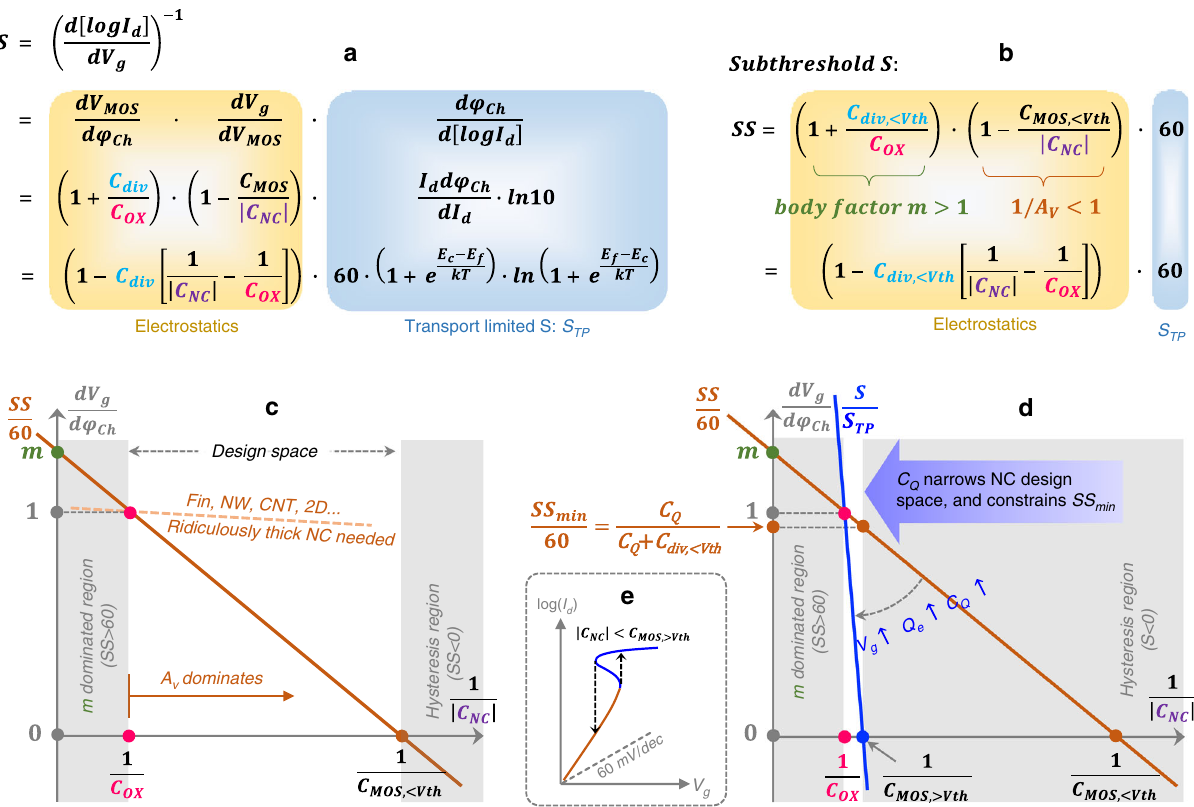
Fig. 2 Impact of electrostatics and quantum capacitance on NC-FET design space. a Formulating I d - V g slope or swing ( S ) by decoupling the electrostatics and transport contributions. S TP is the transport limited S . b S is reduced to subthreshold S ( SS ) in the subthreshold regime. S TP is reduced to 60 mV per decade. Body factor m (>1) and voltage gain A V (>1) compete with each other in determining SS . c Visualizing the SS formula and its physics. In the shaded region on the LHS, m dominates, thus SS > 60 mV per decade. In the shaded region on the RHS, SS < 0, represents the appearance of hysteresis. The design space here is between the two shaded regions where A V dominates and 0 < SS < 60. The dashed line illustrates the ultra-small negative slope of SS /60 line (which implies that SS /60 can be noticeably below 1 only for 1/| C NC | ≫ 1/C ox ) for Fin-, nanowire (NW)-, carbon nanotube (CNT)- and 2D- FETs, indicating very small | C NC |, or equivalently very thick NC layer in these devices is required to obtain NC bene fi t. d A picture that captures all essential quasi-static device physics of NC-FETs. Note that in the near and above-threshold region, the SS /60 line transforms to the S / S TP line, which rotates clockwise due to the rapidly increasing quantum-capacitance C Q with gate bias till a nearly vertical position is reached when the device is fully turned on. Since S in the entire range of I d – V g curve should be guaranteed to be positive, in order to prevent hysteresis in both sub- and super- threshold regimes, the lower bound of 1/| C NC | is extended to 1/ C MOS,>Vth , leading to a narrow NC design space and a minimum hysteresis-free SS ( = C Q /( C Q + C div,<Vth )) at 1/| C NC | = 1/ C MOS,>Vth . e I d - V g curve of an example NC-FET in which 1/| C NC | is designed to be within the shaded region on the RHS of ( d ). Although SS (brown colored portion) is small, negative S (i.e., hysteresis) appears in the near- or above-threshold region (blue colored S / S TP line w.r.t. the SS /60 line, as illustrated in Fig. 2d. In order to guarantee hysteresis-free I - V characteristics, or positive S , not only in the subthreshold regime, but also near- and above- threshold regimes, the lower bound of the forbidden hysteresis region (shaded region on the RHS of Fig. 2d) of 1/| C NC | gets ex- tended from 1/ C MOS,<Vth ( = 1/ C div,<Vth + 1/ C OX ) to 1/ C MOS,>Vth = (1/ C div,>Vth + 1/ C OX ≈ 1/ C Q + 1/ C OX ), which is very close to 1/